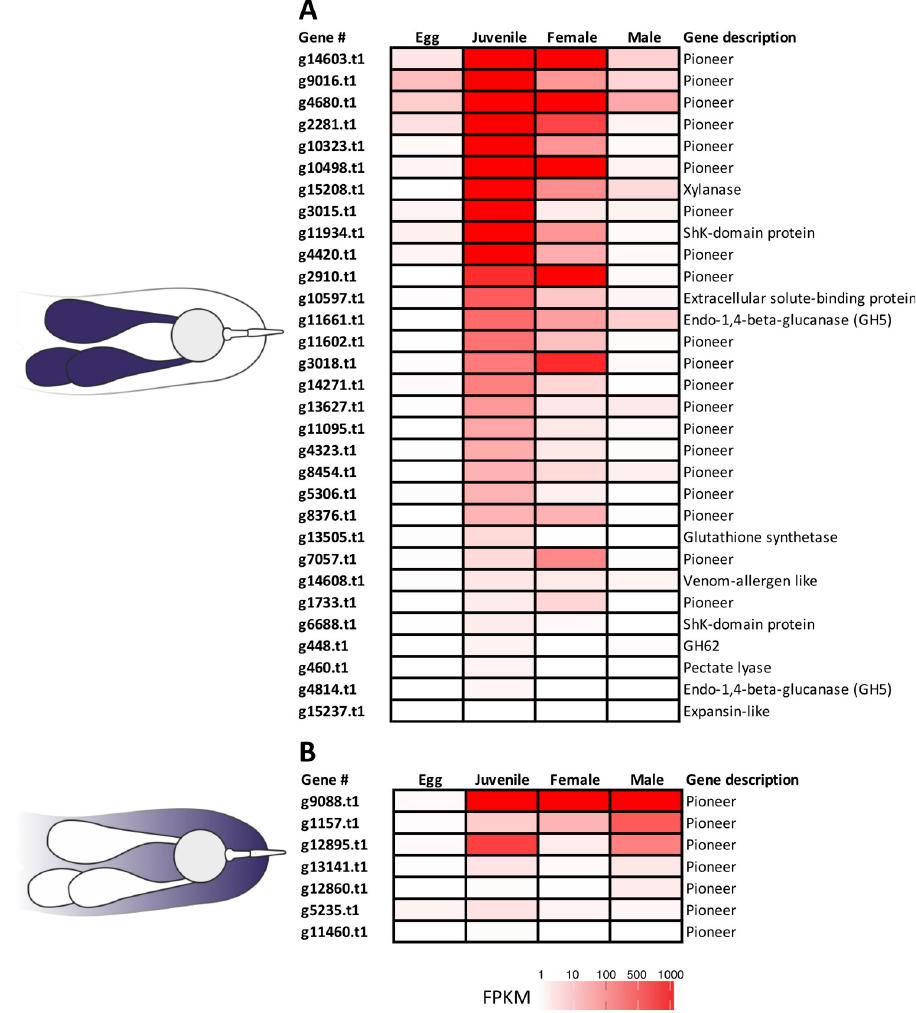
Fig 7. Gene expression analyses of candidate effector genes of Radopholus similis across different nematode developmental stages. (A) Genes validated in the esophageal glands of the nematode as shown in Fig 2. (B) Genes validated in different nematode tissues as shown in Fig 3. Heat maps represent the expression levels calculated using the fragments per kilo base of transcript per million mapped reads (FPKM) of specific nematode developmental stages RNA-seq libraries (Bioproject